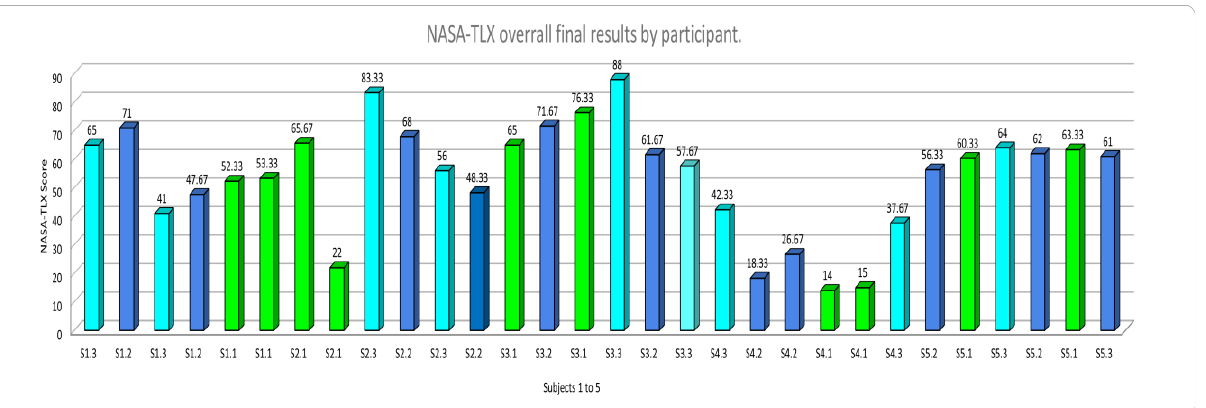
Figure 7. NASA-TLX overall results subjects 6 to 10.